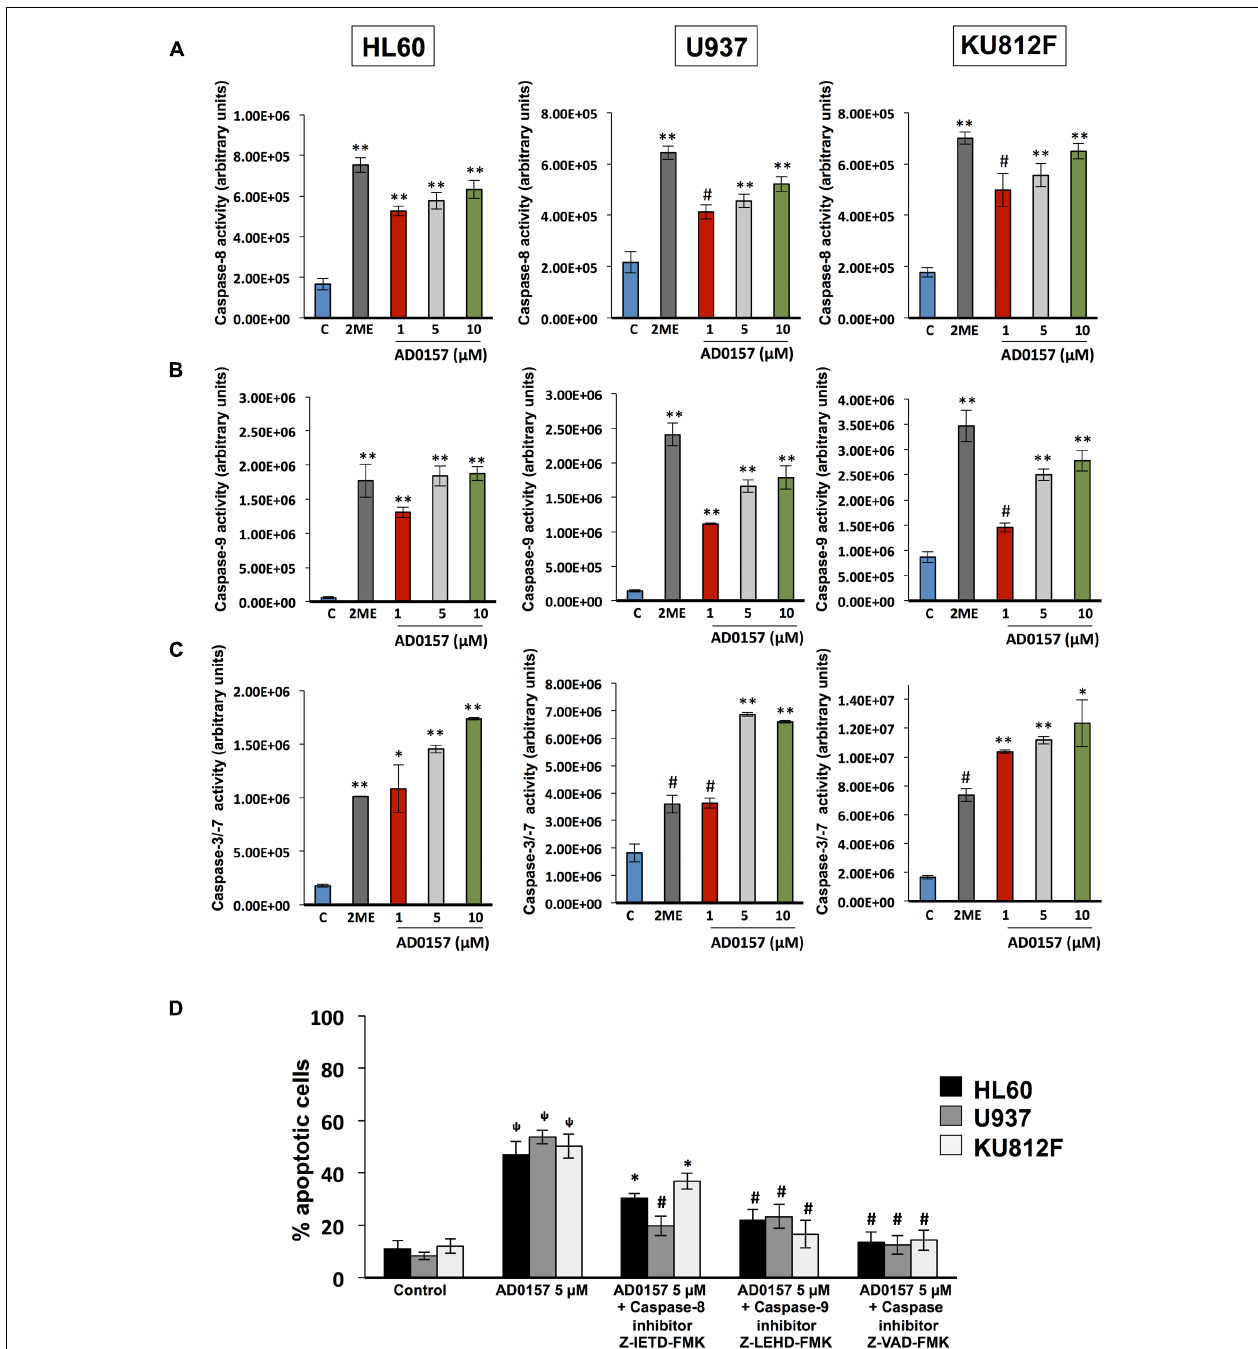
FIGURE 5 | Caspase activation by AD0157 in human myeloid leukemia cells. (A) Effect of AD0157 on caspase-8, (B) caspase-9 and (C) caspase-3, -7 in HL60, U937 and KU812F. The determination of caspase-8, -9 and -3/-7 activities were carried out after leukemia cell treatment with AD0157 or vehicle for 6 h, 30 min and 14 h, respectively. Afterward, Caspase-Glo R (cid:13) 8, Caspase-Glo R (cid:13) 9 and Caspase-Glo R (cid:13) 3/7 reagents were added and the luminescence was recorded at 30 min. Treatment with 10 µ M 2-methoxyestradiol (2ME) was used as a positive control. Data of caspase activities are expressed in arbitrary units ± SD of three independent assays with 3 replicates each one. ∗ p < 0.05, # p < 0.005, and ∗∗ p < 0.001 versus control. (D) Percentage of subG1 population (apoptotic cells) after pre-treatment for 2 h with either caspase-8 inhibitor Z-IETD-FMK, caspase-9 inhibitor Z-LEHD-FMK or pan caspase inhibitor Z-VAD-FMK, followed by AD0157 5 µ M treatment for 14 h and flow cytometric analyses. Data are expressed as means ± SD of three independent experiments. (cid:57) P < 0.005 versus untreated controls. ∗ p < 0.05 and # p < 0.005 versus cells treated with AD0157 5 µ M in absence of caspase inhibitors.